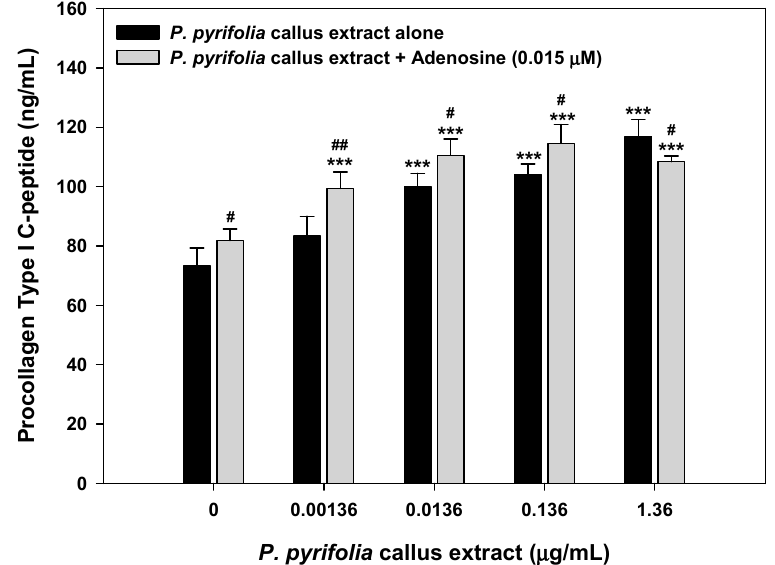
Figure 5. Procollagen type I C-peptide synthesis by CCD-986sk cells after treatment with P. pyrifolia callus extract alone or in combination with adenosine (0.015 µM) for 24 h. Values are means ± standard deviation ( n = 6 per group). *** p < 0.001 compared to untreated control. # p < 0.05, ## p < 0.01 compared to the same concentration of P. pyrifolia callus extract alone.